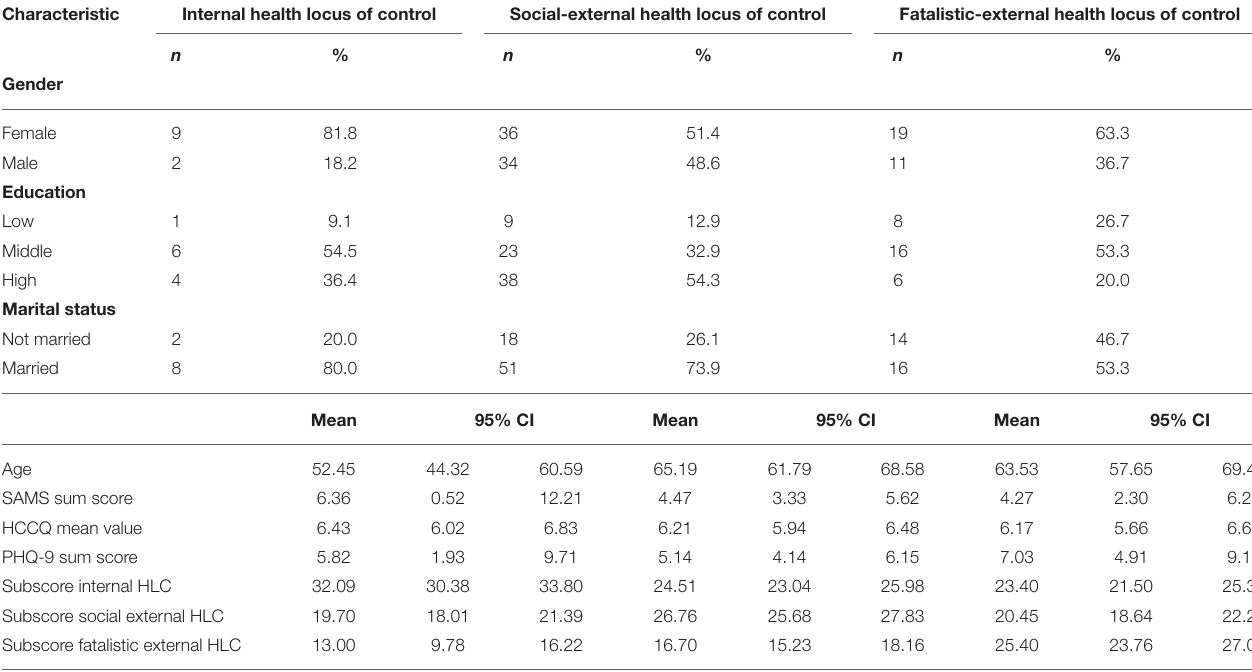
TABLE 2 | Characteristics of people with predominantly internal, social external, and fatalistic external health locus of control. Characteristic Internal health locus of control Social-external health locus of control Fatalistic-external health locus of